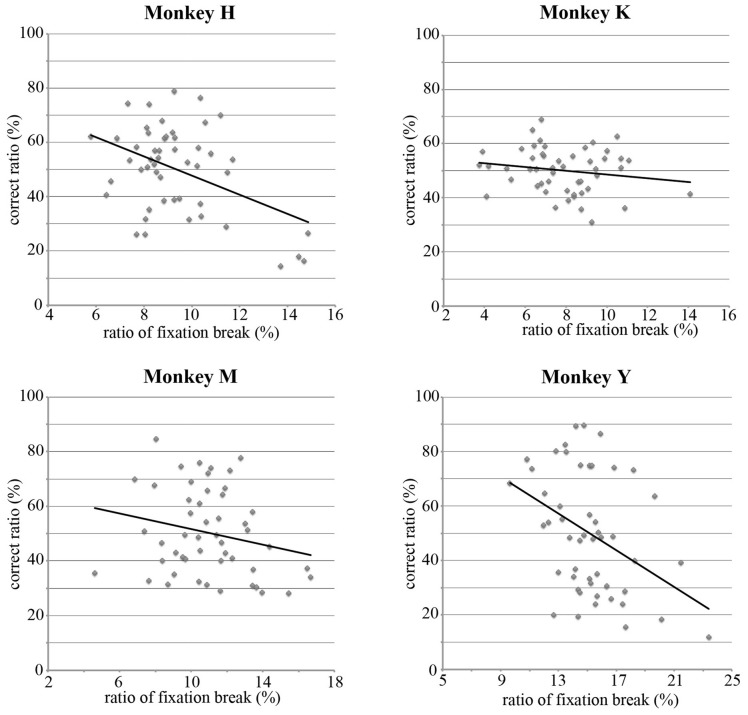
Correlations between the choice ratio and the ratio of the fixation break during the hold period for each stimulus. For four monkeys, the choice ratios were negatively correlated with the ratios of the fixation break (Monkey H, r = −0.448, p < 0.001; Monkey K, r = −0.172, p > 0.1; Monkey M, r = −0.219, p > 0.1; Monkey Y, r = −0.396, p < 0.005). Since monkeys were required to maintain looking at the selected stimulus for 3–6 s to obtain a reward, these results suggest that the choice ratios reflect the strength of the preference for visual stimuli.